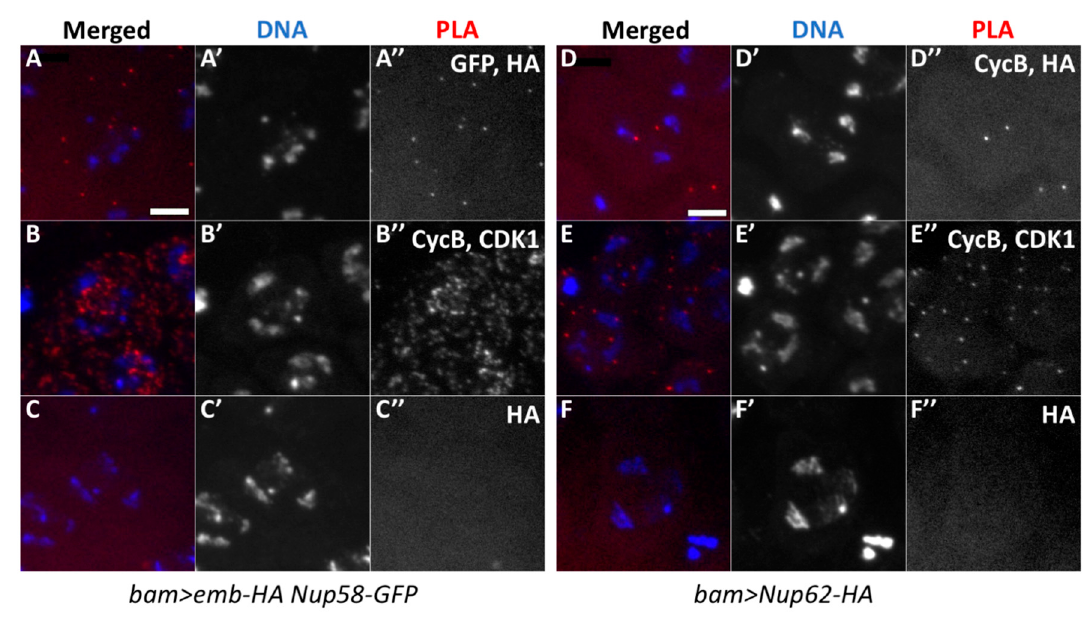
Figure 8. In situ PLA to detect protein complexes containing Emb and Nup58 of the Nup62 complex, and complexes containing Nup62 and CycB. ( A ) In situ PLA for detection of complexes containing Emb and Nup58. The cells expressing Emb-HA and Nup58-EGFP were analyzed using anti-HA and anti-GFP antibodies. ( B ) The assay with anti-CycB and anti-CDK1 antibodies as the positive control (48.5%, n = 429), ( C ) The assay with only anti-HA antibody as the negative control (1.4%, n = 287). ( D – F ) In situ PLA to detect complexes containing Nup62 and CycB. ( D ) Assay of spermatocytes expressing Nup62-HA with anti-HA and anti-CycB antibodies. ( E ) Anti-CycB and anti-CDK1 antibodies were used as positive controls (87.2%, n = 358); ( F ) with only anti-HA antibody as the negative control (1.3%, n = 378). The PLA signal is in red (white in ( A” – F” )) and DAPI in blue (white in ( A’ – F’ )).